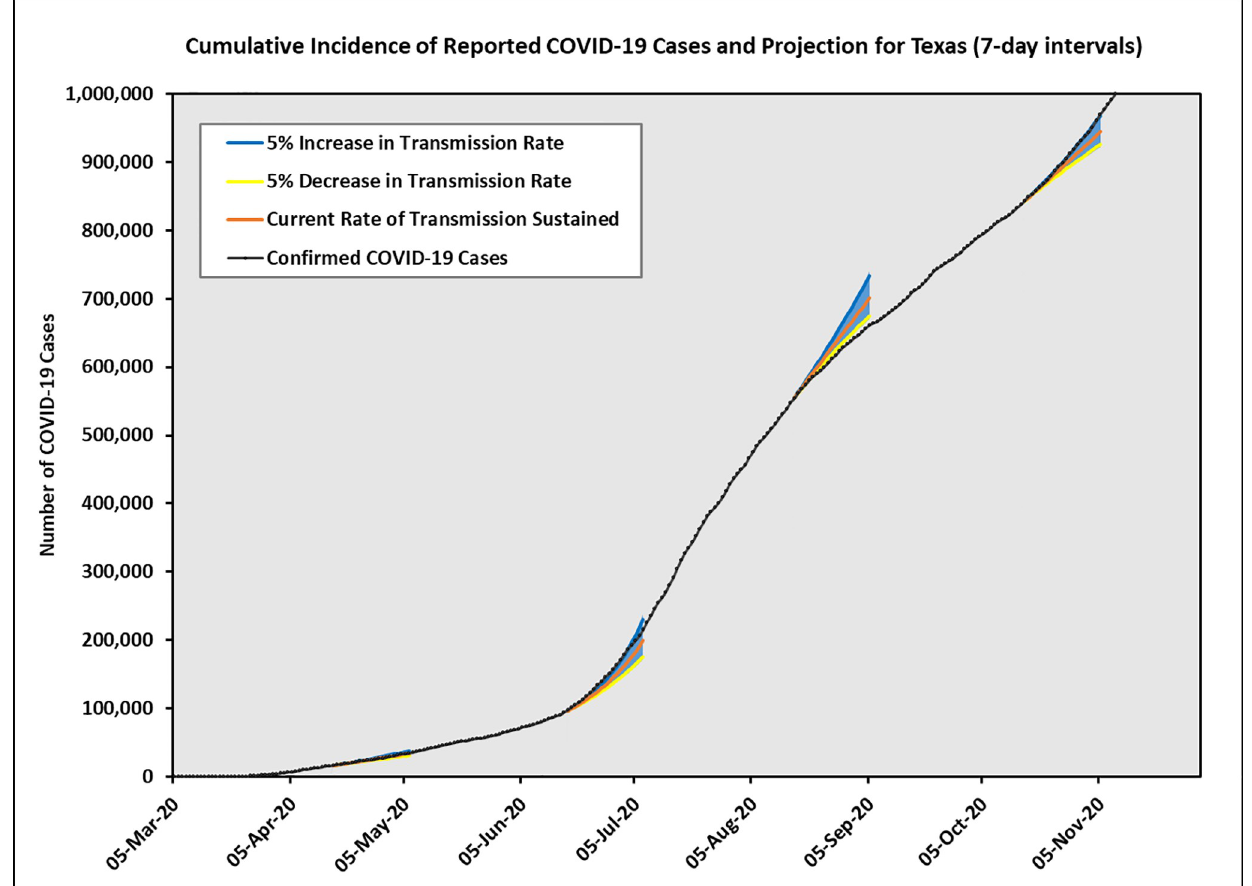
Fig 3. Texas predicted cumulative incidence cases using 7-day intervals. Three solid lines represent the predicted cases corresponding to current rate of transmission sustained, 5% increase in transmission rate, and 5% decrease in transmission rate. The shaded areas indicate prediction